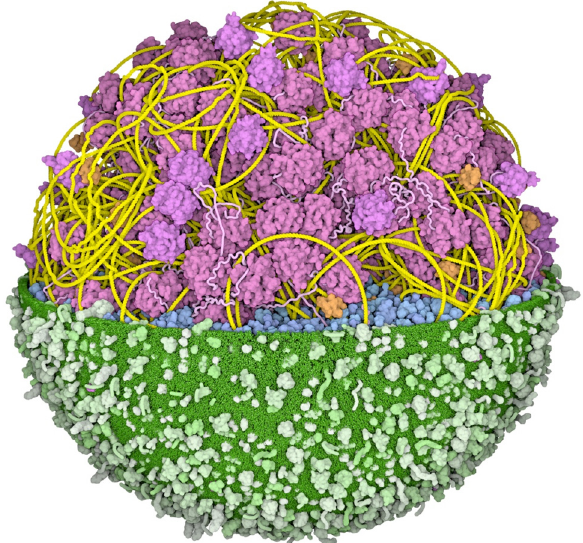
Figure 5: 3D whole cell model of syn3A minimal cell. The upperhalfisclippedawaytoshowtheDNA,polymerases, mRNA, and ribosomes. Image created by Ludovic